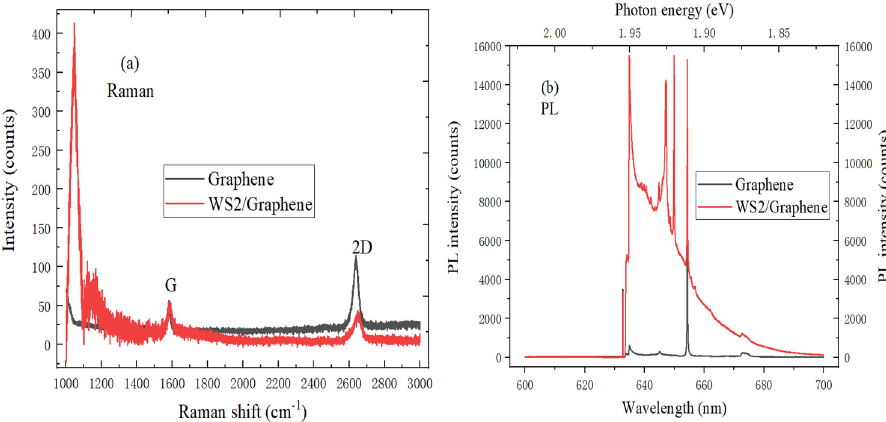
Figure 10. ( a ) Raman spectrum (10 mW, 633 nm), ( b ) PL spectrum (20 mW, 633 nm) comparison of graphene and WS 2 /graphene heterostructure.